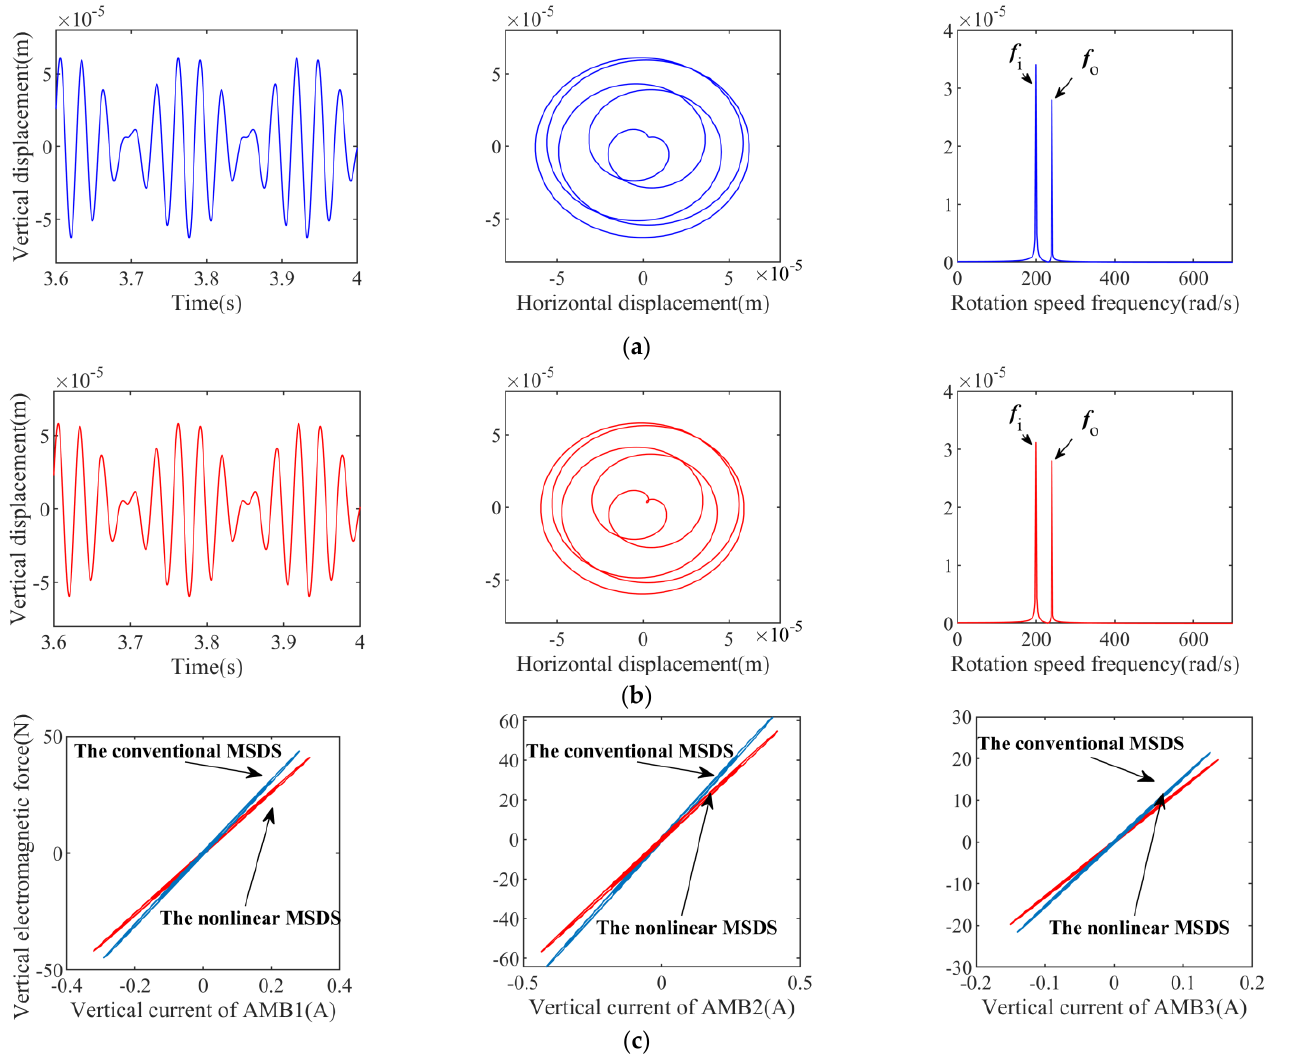
Figure 9. Unbalanced responses of the disk 1 ( ω i = 200 rad/s, F L = 0 N). ( a ) Unbalanced response of the conventional MSDS. ( b ) Unbalanced response of the nonlinear MSDS. ( c ) Bearing capacity curves of AMB 1, AMB 2, and AMB3.